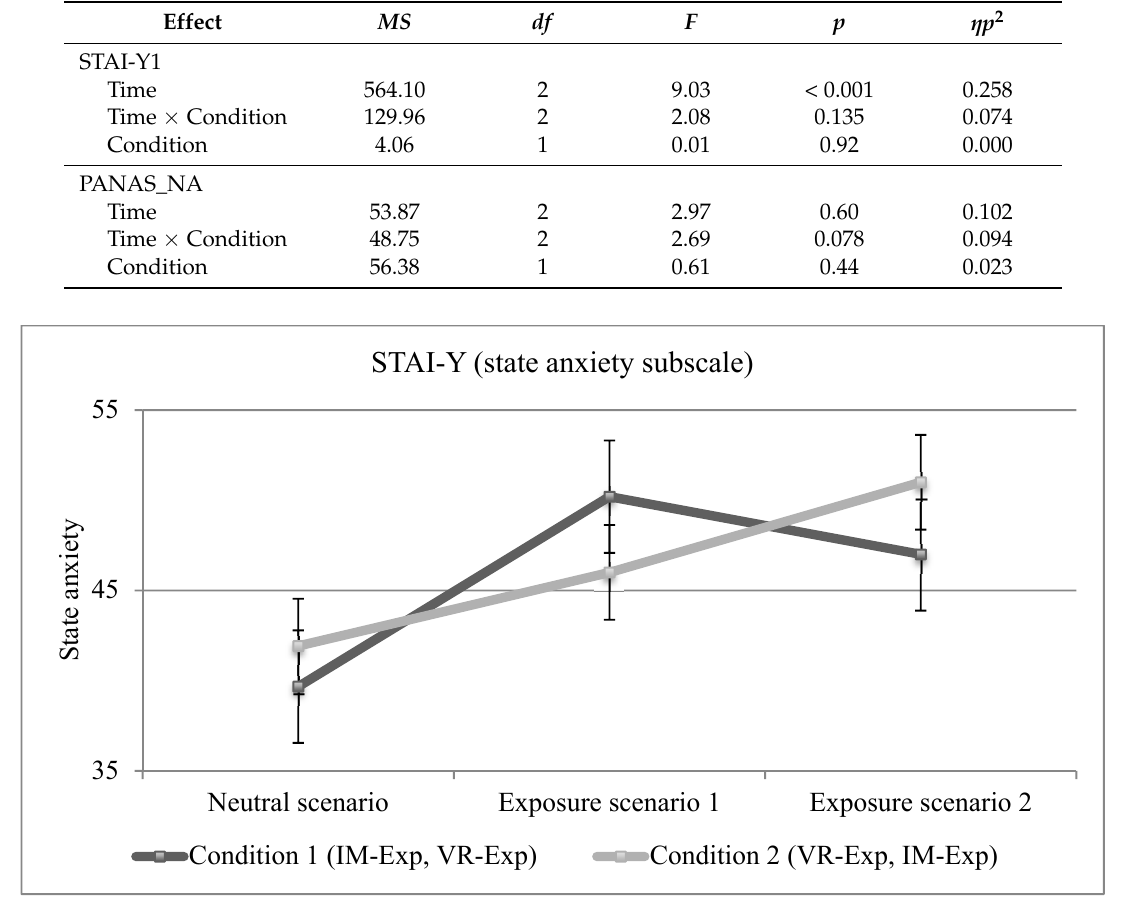
Figure 1. Illustration of the differential impact of exposure to a neutral scenario in virtual reality, a personalized scenario in imagination (IM-Exp) and a standardized scenario in virtual reality (VR-Exp) on the self-report measure of anxiety.